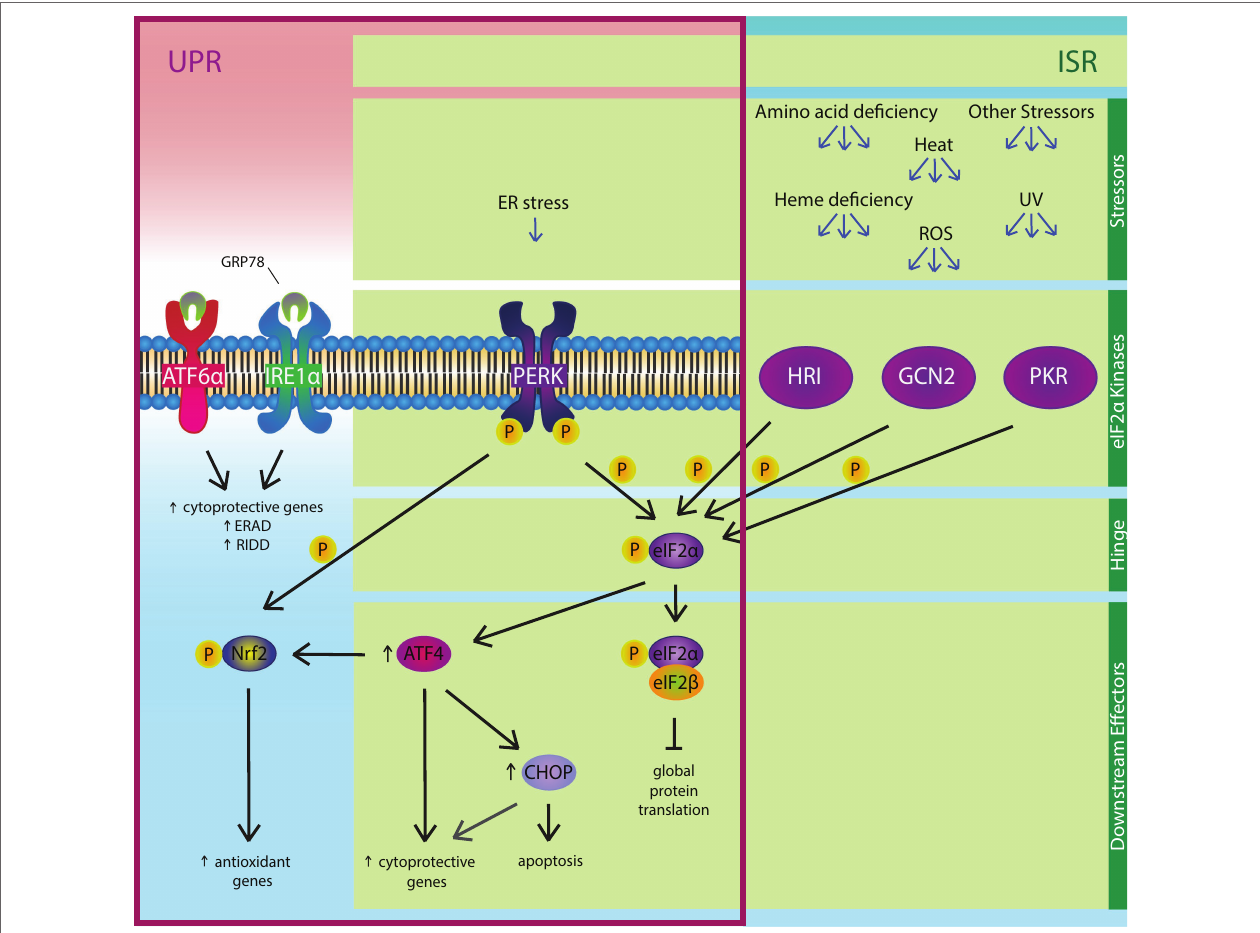
FIGURE 4 | The Integrated Stress Response (ISR). The PERK pathway of the UPR is also a member of the ISR. Various stressors, including ER stress, amino acid deficiency, ultraviolet rays, heat, ROSs, and heme deficiency, can activate one or more of the four eIF2 α kinases: PERK, HRI, GCN2, and PKR. The ISR hinges on eIF2 α , which is phosphorylated by the four kinases. Phosphorylated eIF2 α binds eIF2 β , a key component of an essential complex involved in initiating protein translation, to inhibit global protein synthesis, except ATF4 and ATF4-regulated genes like CHOP. ATF4 positively regulates expression of cytoprotective genes, as well as upregulating CHOP, which can induce apoptosis under chronic ER stress conditions. Independent of the ISR, ER stress-induced activation of the PERK pathway can also enhance the anti-oxidant response by upregulating genes via the direct phosphorylation of nuclear factor erythroid 2-related factor